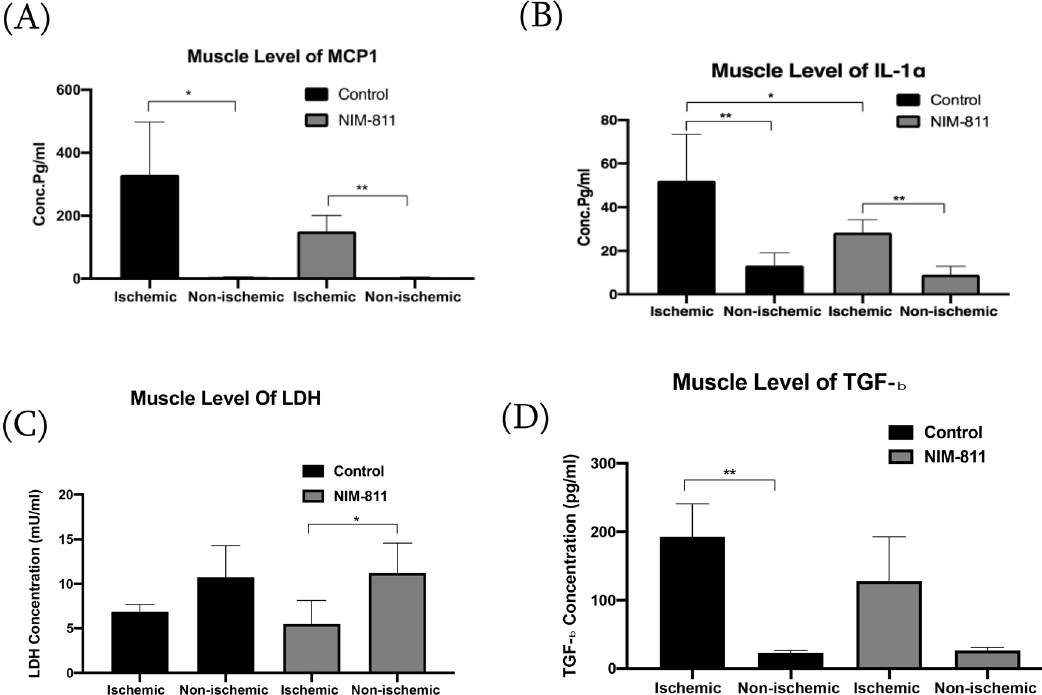
Figure 8. Tissue cytokine levels in male mice after hindlimb ischemia–reperfusion and treatment with NIM- 811 and LDH and TGF-β protein levels in gastrocnemius muscle of female mice. ( A , B ) Tissue IL-1α, and MCP1 levels decreased in the ischemic muscle of male mice treated with NIM-811 compared to the ischemic muscle of the control group. ( C ) LDH concentration in the protein lysate from gastrocnemius muscle in female mice Indicates significant differences between ischemic muscle of the NIM-811 treated group compared to non- ischemic muscle of the same group. ( D ) Acid activated protein lysates from gastrocnemius muscle samples were assessed for TGF-β1 by ELISA and compared to a standard curve in female mice indicates significant differences between ischemic muscle of control group compared to non-ischemic muscle of the same group. **P < 0.01 *P <